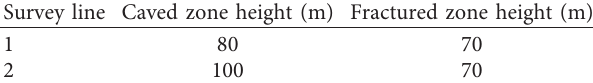
Table 4: EH4 survey results showing the height of the two zones in the gob.